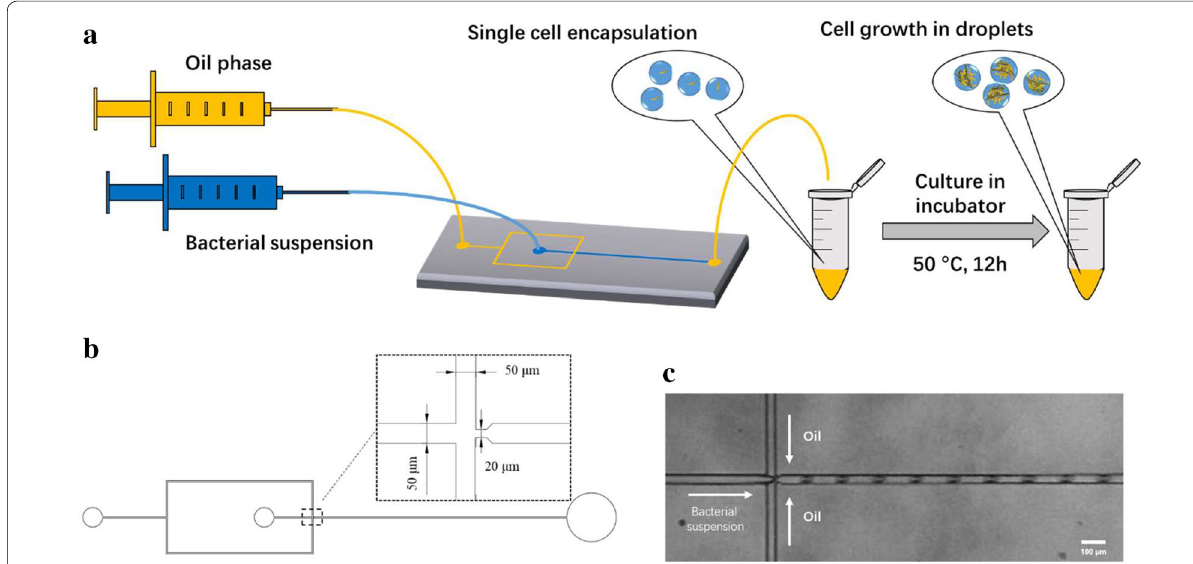
Fig. 1 Encapsulation and growth of B. coagulans in microdroplets. a Schematic illustration of droplet generation and off-chip cultivation. The device had a uniform channel depth of 25 μm. Microdroplets were generated in a flow-focusing microfluidic device and collected in an EP tube for incubation at 50 °C for 12 h. b The blueprint and dimensions of the flow-focusing microfluidic chip. All channels had a uniform depth of 25 μm. c A bright-field microscopy image showing the generation of microdroplets. The bacterial suspension flow and oil flow are indicated by white arrows. Scale bar: 100